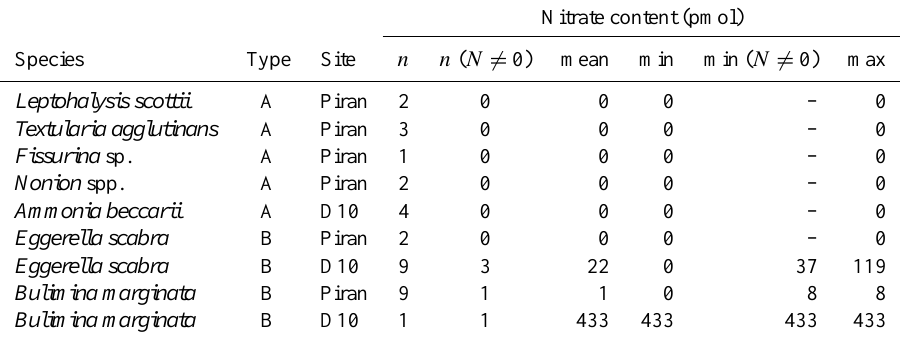
Fig. 4. Relationship between sediment depth and foraminiferal density for the nine major species at all sampling times. Open circles and triangles represent replicate cores 1 and 2, respectively. Table 6. Nitrate contents (in pmol) for seven different species of the two response-types A and B from two sampling sites (the Gulf of Trieste station Piran and the station D10 on the west coast of the Adriatic Sea). The number of tested individuals ( n ), the number of individuals with a nitrate content different from 0, the mean nitrate content, the minimum measured nitrate content, the minimum nitrate content different from 0 and the maximum measured nitrate